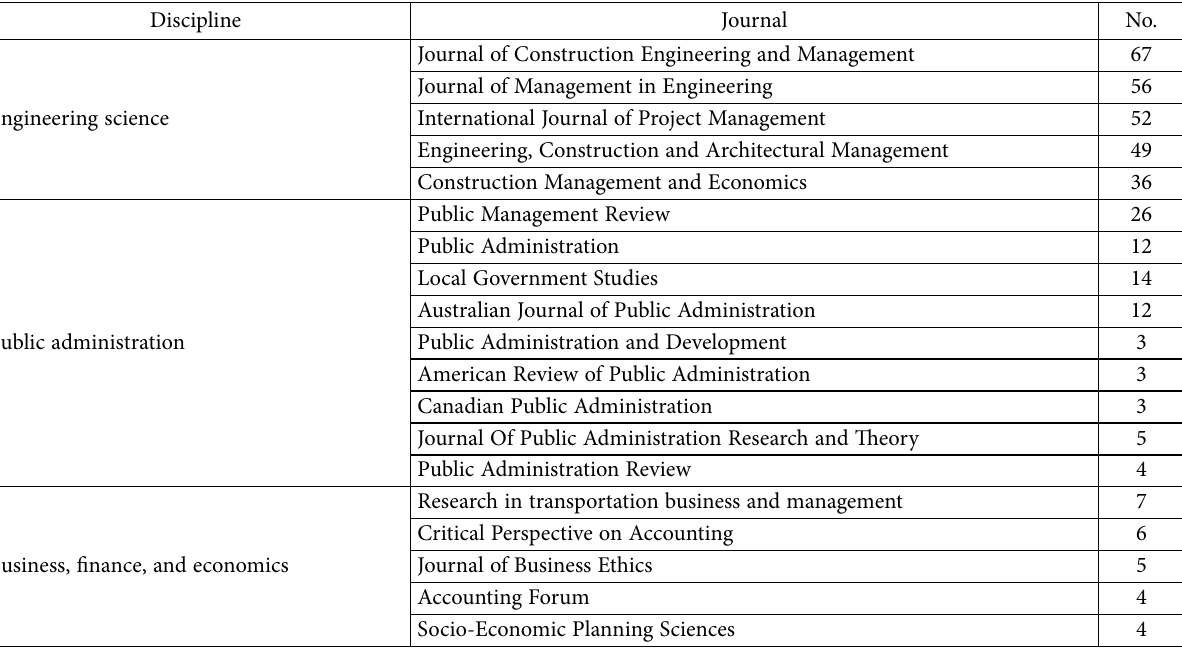
Table 1. The number of publications of targeted journals